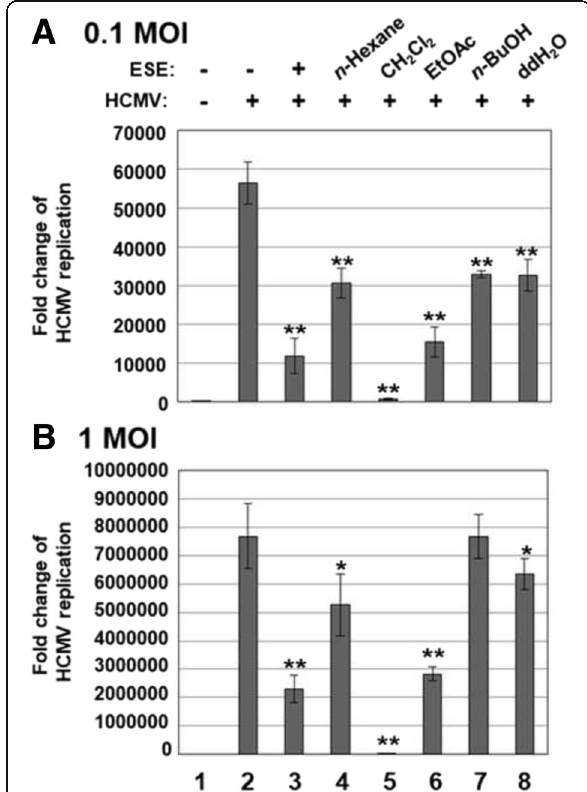
Fig. 2 Effects of solvent fractions of ESE on HCMV replication. HFF cells were mock-infected (lane 1) or infected with HCMV-Towne at MOI of ( a ) 0.1 or ( b ) 1 (lanes 2 to 8) and treated with DMSO (lanes 1 and 2), ESE (lane 3) or n -Hexane (lane 4), CH 2 Cl 2 (lane 5), EtOAc (lane 6), n - BuOH (lane 7) or ddH 2 O (lane 8) fractions of ESE at 50 μ g/ml. At 3 days after infection, total DNA was harvested and the relative amounts of viral DNA were measured via qPCR using primers specific for UL123. Significant difference between samples was determined based on P values obtained from Student ’ s t test (* P < 0.01, ** P < 0.001)